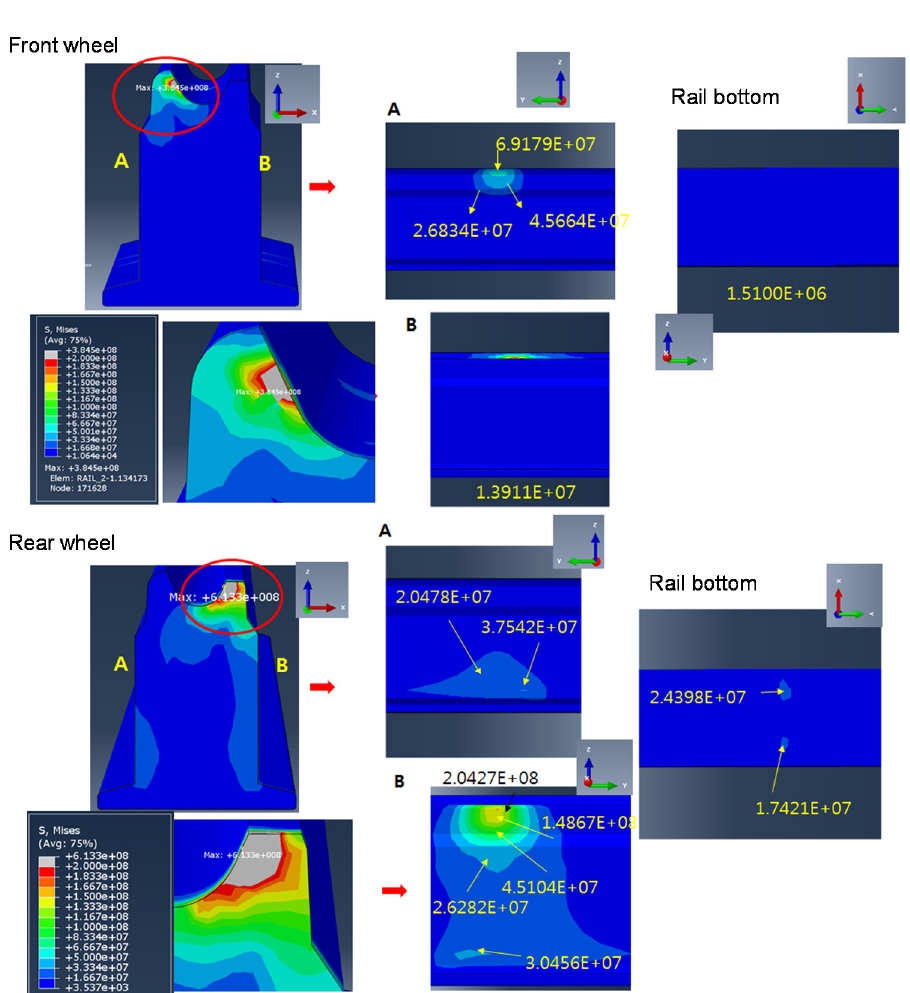
Figure 16. Structural analysis results (von Mises stress) of the rail when the wheels are placed between the railroad ties.